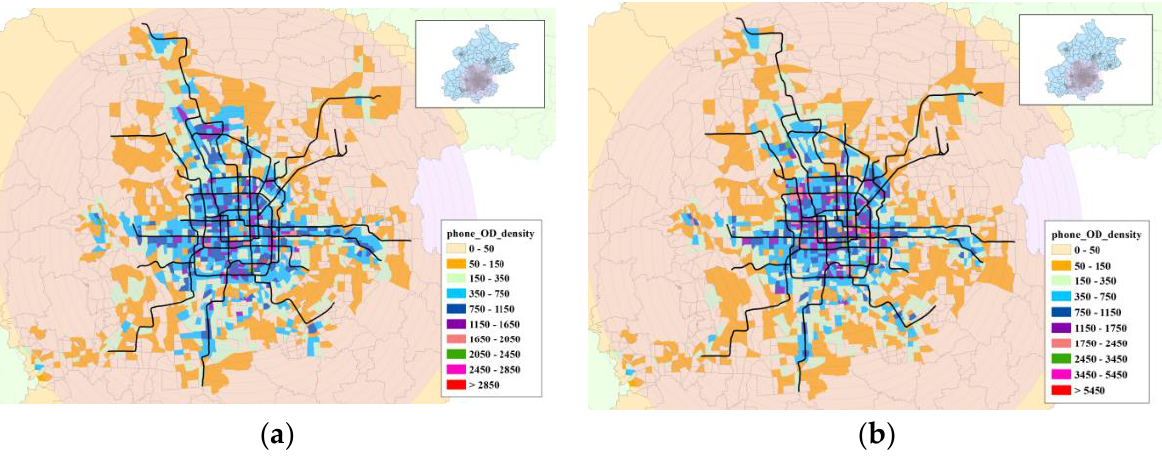
Figure 13. OD distribution in the morning peak, for ( a ) origin and ( b ) destination.